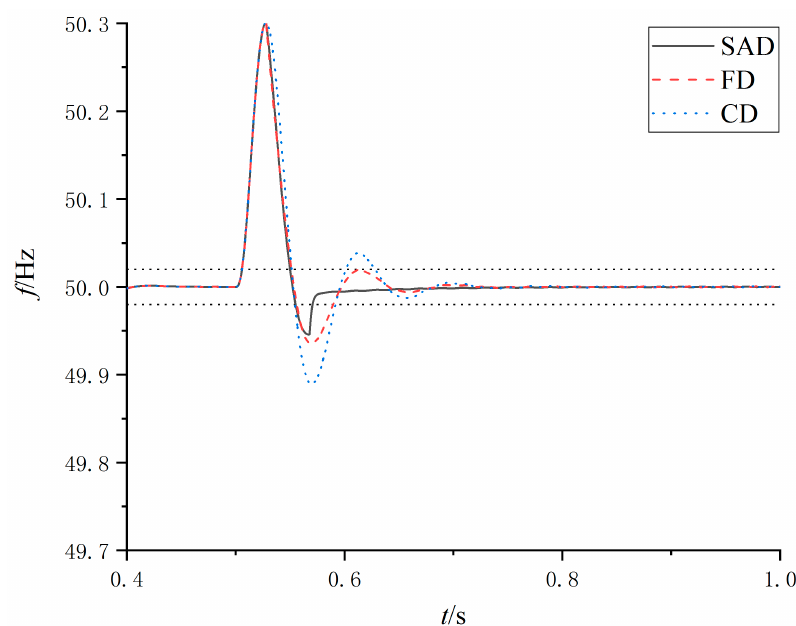
Figure 13. Comparison of frequency under di ff erent damping control strategies in case of a short-circuit fault.